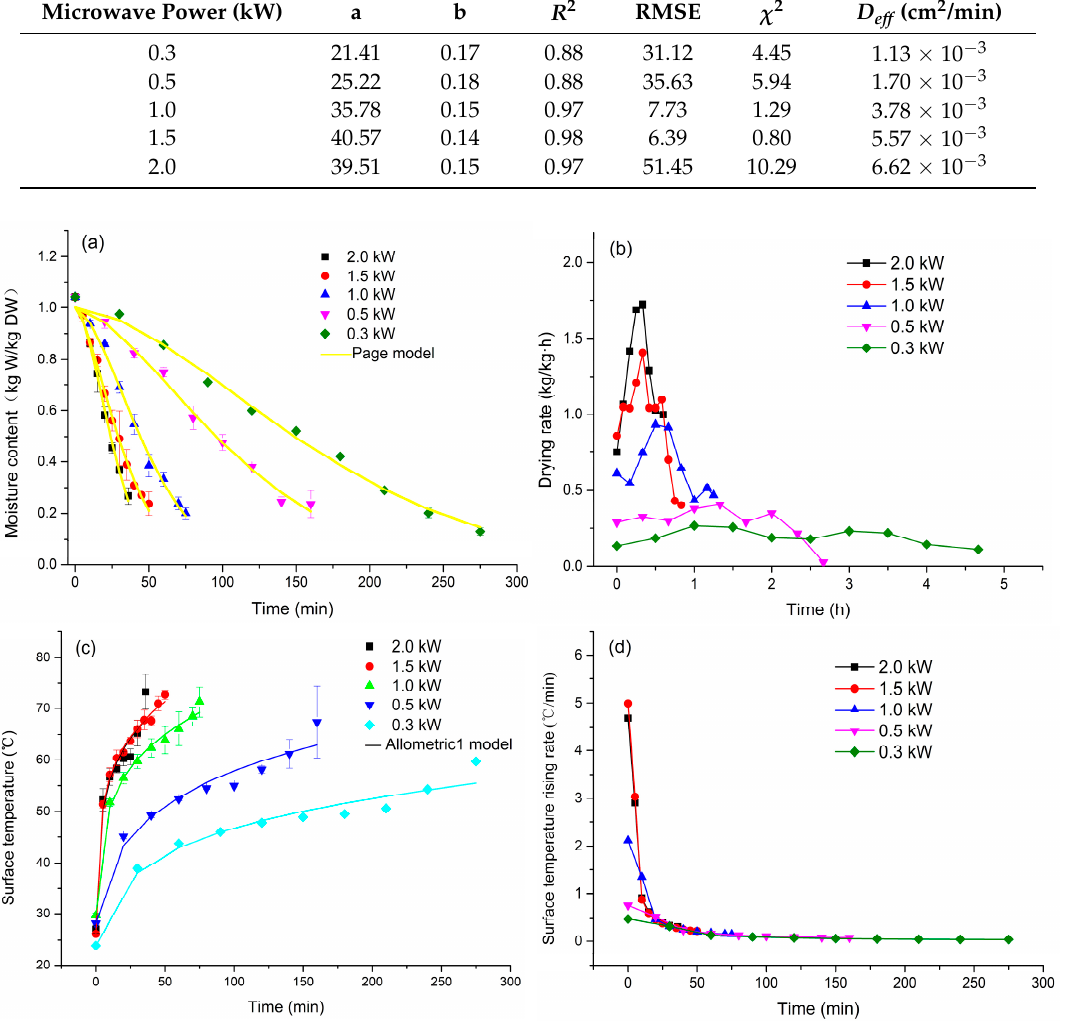
Figure 1. Effect of microwave power setting on drying and surface temperature rise curves of green coffee beans during MVD at − 0.085 mPa: ( a ) Moisture ratio vs. drying time; ( b ) drying rate vs. drying time; ( c ) surface temperature vs. drying time; and ( d ) surface temperature rising rate vs. drying time.